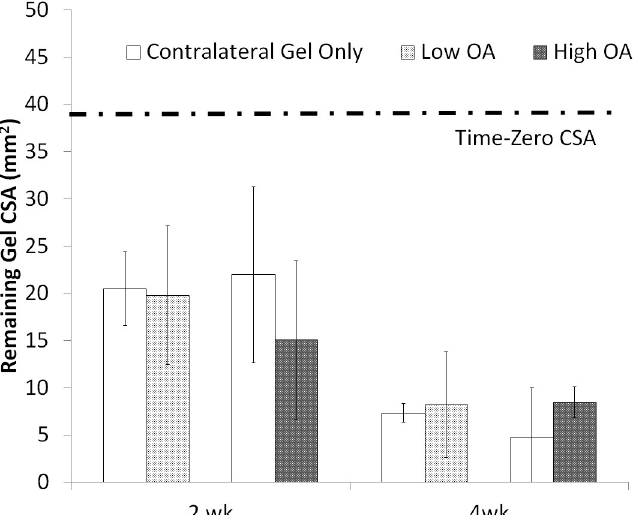
Fig 8. Analysis of gel resorption at 2 and 4 weeks. At implantation, the CSA of a prototypical gel was 39 mm 2 . Two weeks after the repair, the averaged CSA of the remaining gel was approximately half of its original cross-section (24%-80%)across all groups, and by four weeks the remaining gel was less than one quarter (4%-31%)of its originalcross-section. No significantdifference was found betweenthe CSA of the remaining gel in muscles with treatment (low or high OA) and contralateral muscles with no treatment (gel only) at either 2 or 4 weeks.